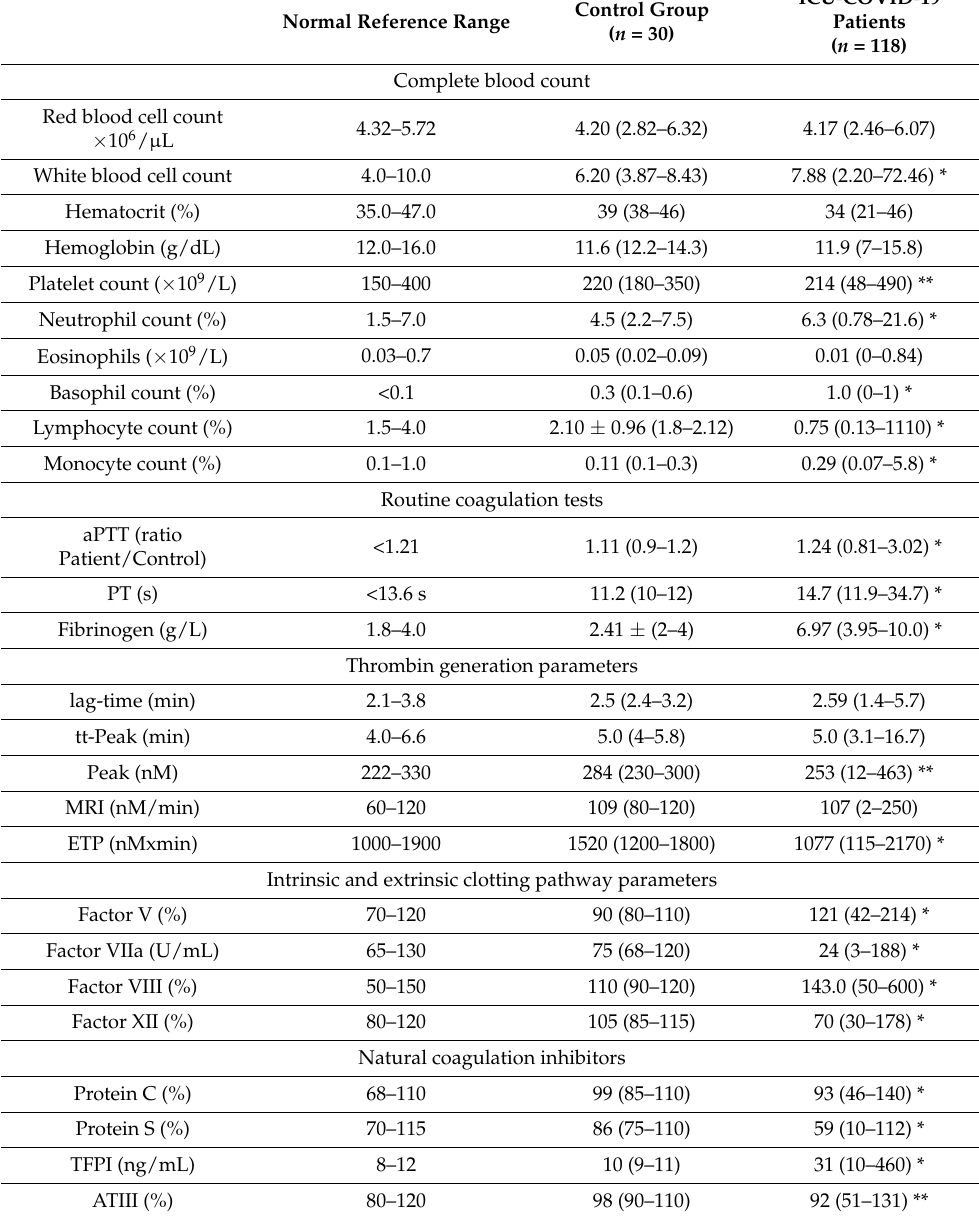
Table 2. Levels of biomarkers of hypercoagulability, cellular activation, and inflammation in patients with critical COVID-19 and controls. Values are median